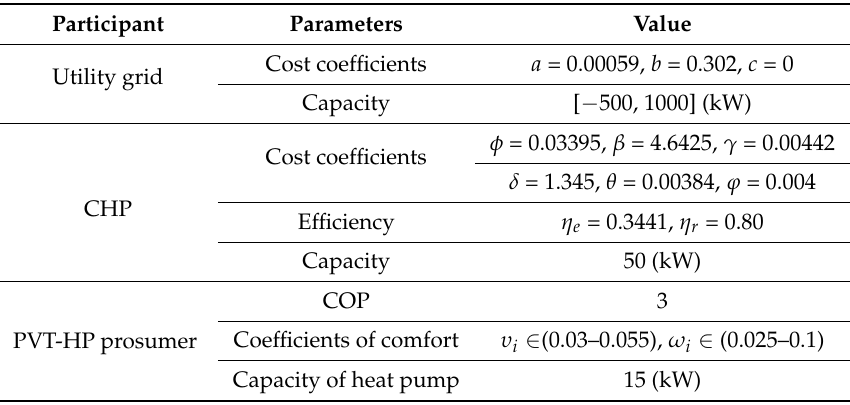
Table 1. Parameters of